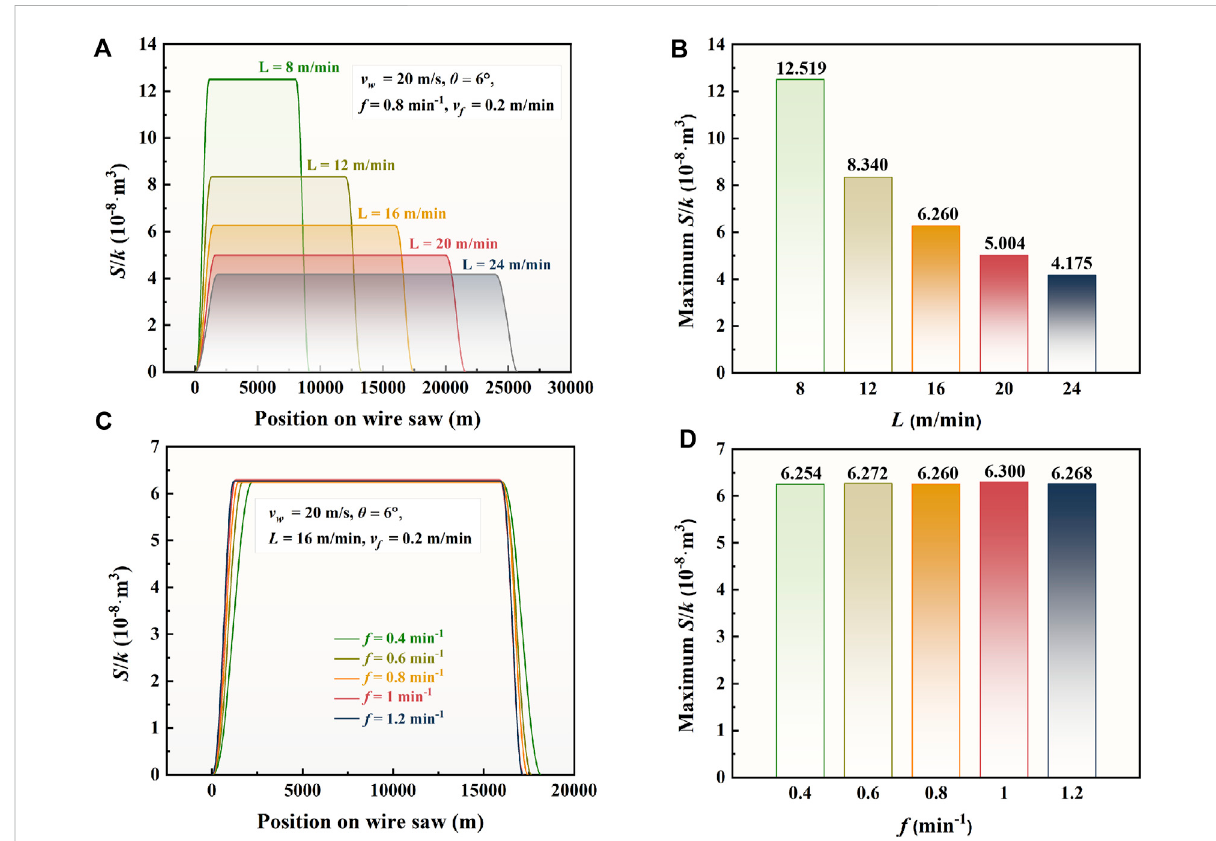
FIGURE 9 Variation of the wear amount of the wire saw on the rectangular workpiece and reciprocating frequencies. (A,B) illustrate the change in the setting out length will have an impact on the time difference between the take-up and pay-out. Under the condition that the wire feed length and speedremain unchanged,itdirectly affectsthewirefeedinterval betweentwocycles,whichinturnaffectsthenumberofsuperimpositions,thereby affecting the wear of the wire saw. (C,D) illustrate when the number of reciprocations changes, the time of the cycle will change, which will affectthetimeparameter ofEq.(1).Theincreaseof t b and t f makesthevaluetendtodecrease. Atthesametime,thedifferencebetweentband t f will affect the wire feeding length of each cycle feeding stage, by increasing the wire feeding length and then increasing the number of superpositions, the in fl uence of the number of reciprocations on the wear of the wire saw remains roughly